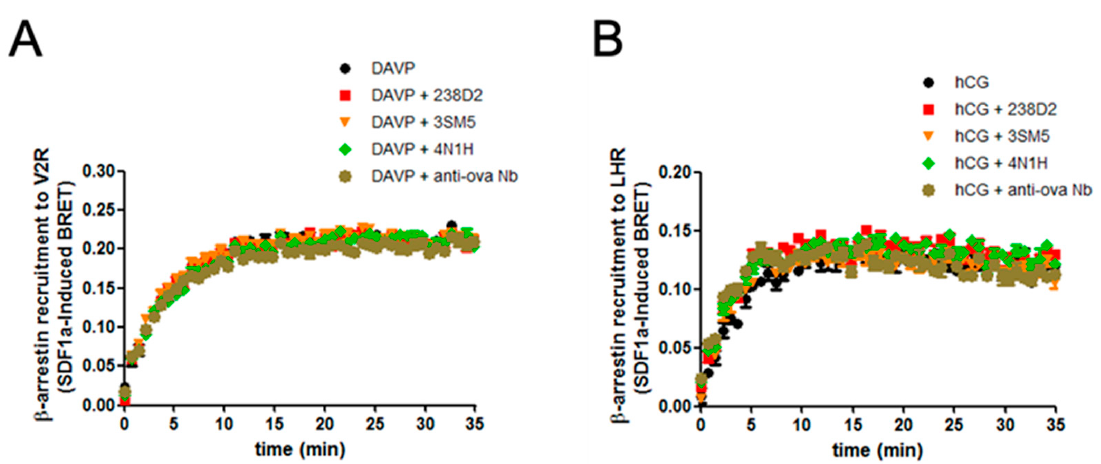
Figure A3. Epitopes of 238D2, 3SM5, and 4N1H on CXCR4. ( A ) Model of 238D2 3D structure docked on the CXCR4 according to MAbTope method. B to E. Top view of CXCR4 extracellular part ( gray ) where the ECL2 is shown in blue. ( B ) In yellow are represented 238D2 epitope residues experimen- tally determined by Jähnichen and coll. [15]. ( C – E ) Core epitopes as predicted by MAbTope for 238D2 ( red ), 3SM5 ( orange ), and 4N1H ( green ).